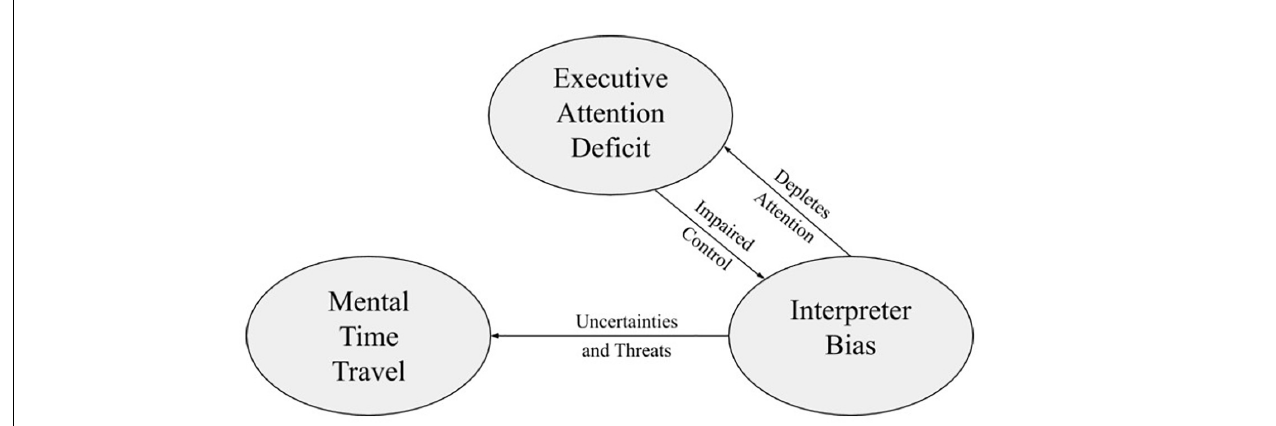
FIGURE 2 | Model of generalized anxiety